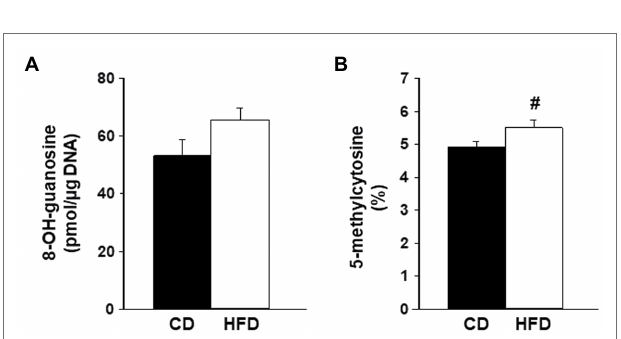
FIGURE 3 | Levels of oxidative stress biomarkers in endometrial-like lesions. Genomic DNA isolated from lesions of recipients fed CD or HFD was compared for (A) levels of 8-OH-guanosine and (B) percent of methylated cytosine (5-methylcytosine) in total DNA cytosine content, following procedures described under Materials and Methods. Data (mean ± SEM) are from n = 4 individual mice per diet group. # 0.10 < p < 0.05 by Student’s t-